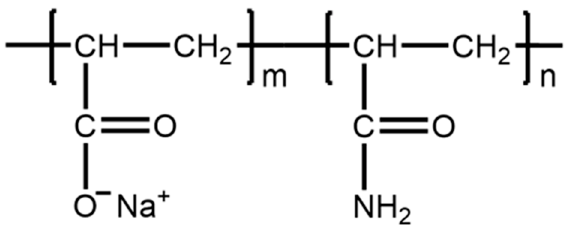
Figure 13. Chemical structure of poly(acrylamide-co-sodium acrylate).